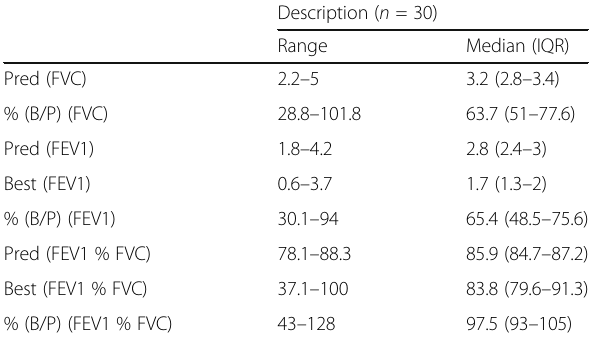
Table 6 Different patterns of ILD Interstitial lung disease (ILD)